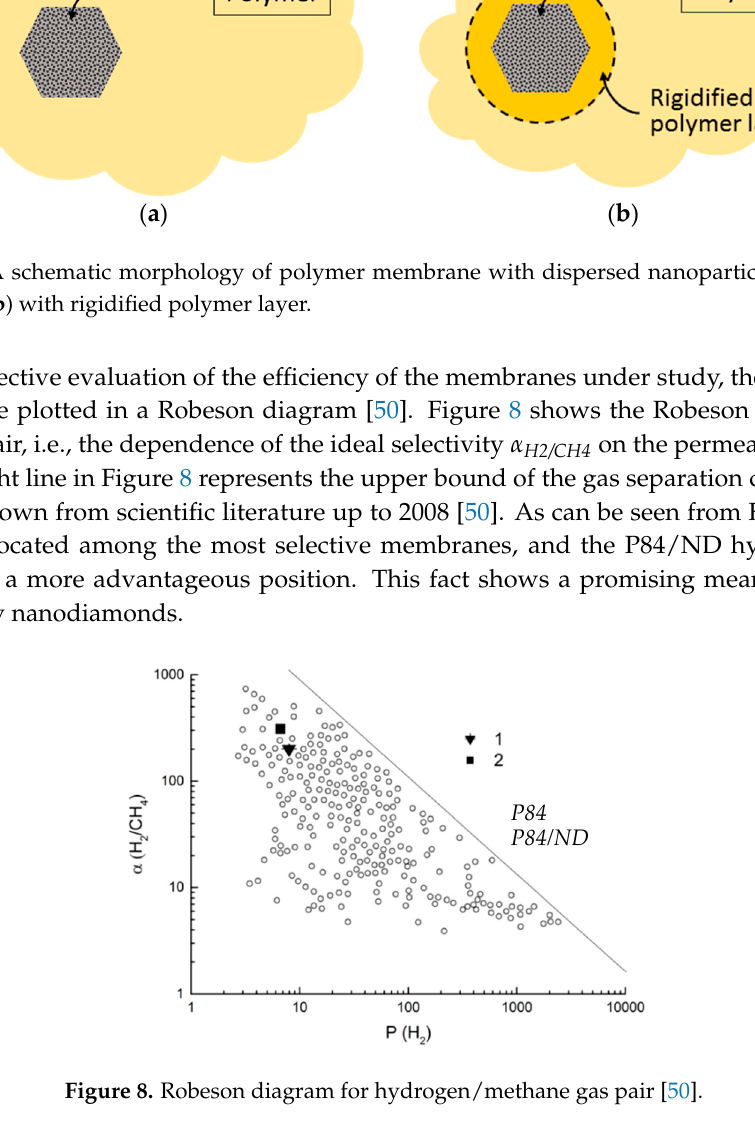
Table 5. Gas transport properties of modified polyimide membranes.